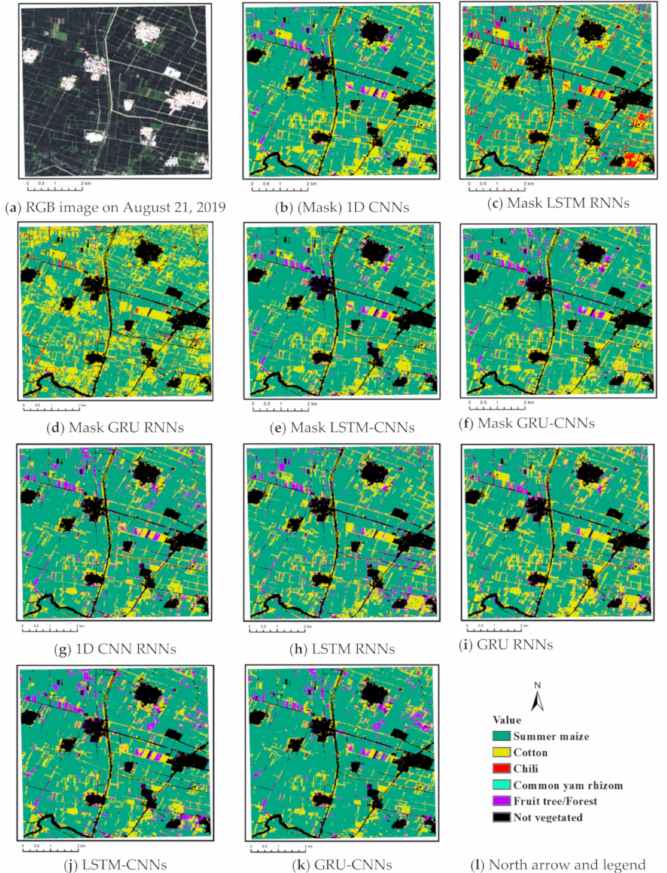
Figure 11. The crop type maps attained by the five deep learning models. ( b – f ) are the results with unfilled Sentinel-2 time series data; ( g – k ) are the results with filled Sentinel-2 time series data.